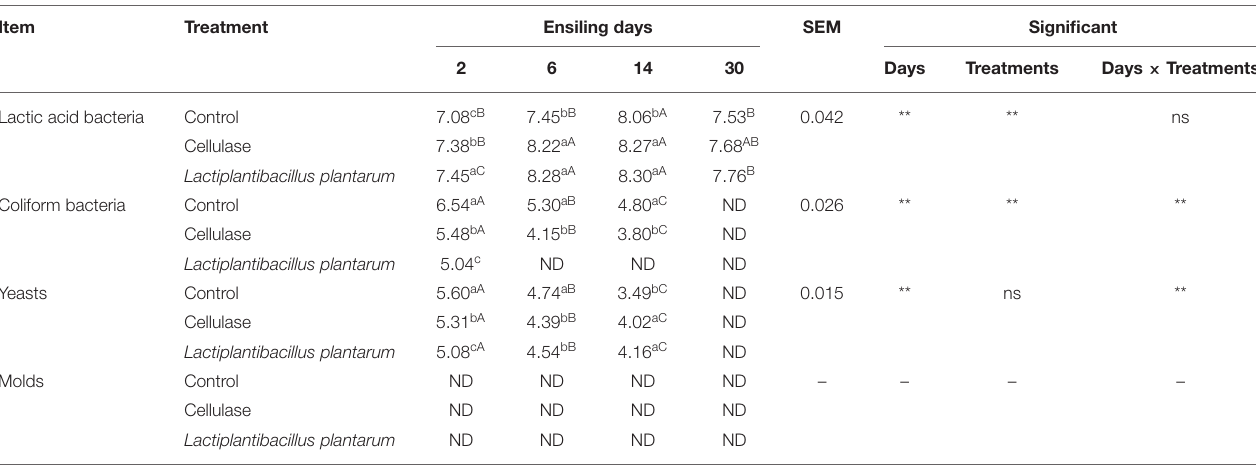
TABLE 4 | Microbial population of ensiled Cassia alata (log 10 CFU/g FM).